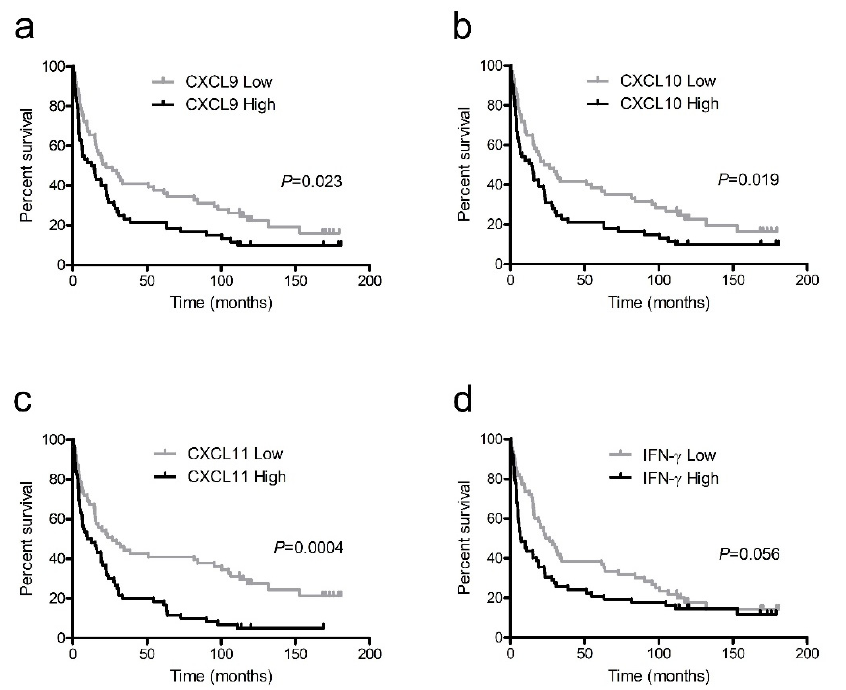
Figure 3. Kaplan–Meier survival curves for overall survival in non-small cell lung cancer patients with high and low levels of interferon (IFN)- γ -inducible chemokines CXCL9 ( a ), CXCL10 ( b ), and CXCL11 ( c ) and IFN- γ ( d ).